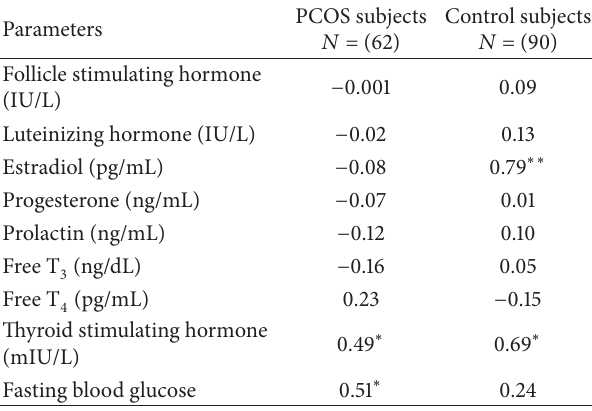
Table 2: Correlation coefficient of serum leptin with different variables in PCOS and control subjects.